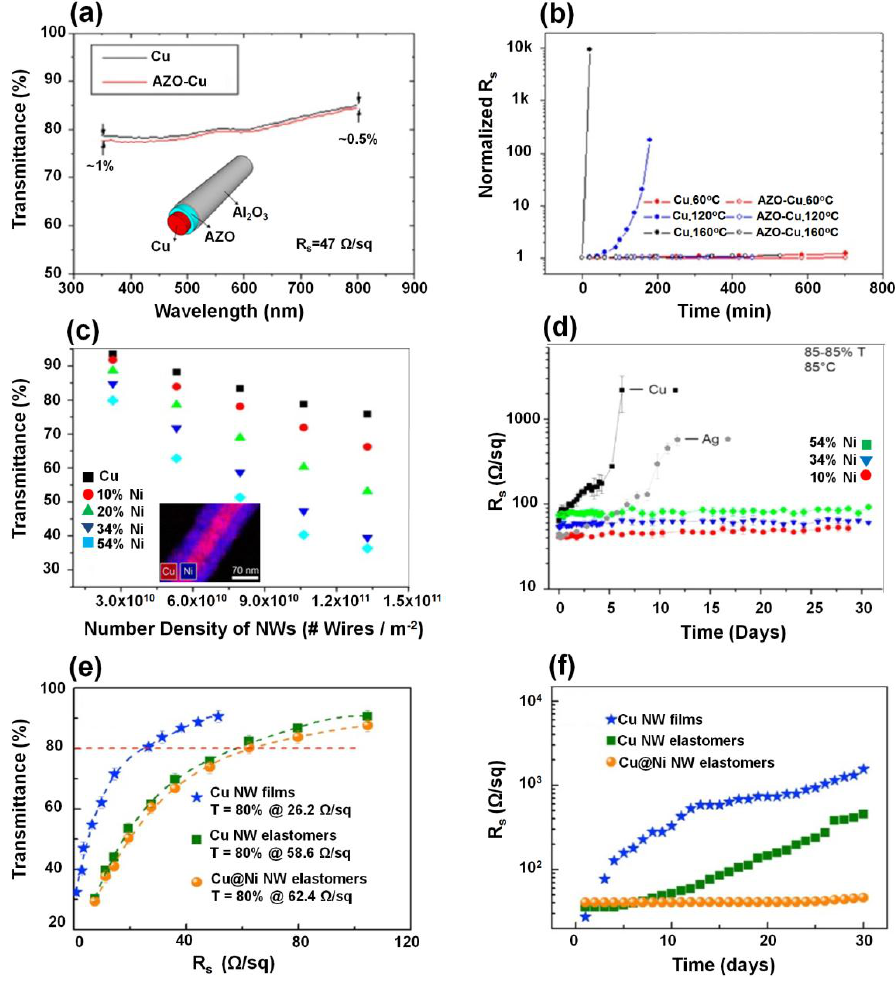
Figure 6. ( a ) Transmittance of electrospun Cu nanofibers before and after atomic layer deposition (ALD); inset is a cartoon (not to scale) of the Cu@AZO/Al 2 O 3 nanofiber ( b ) Normalized sheet resistance ( R s ) of bare and protected Cu NWs vs. baking time at 80, 120, and 160 °C. Solid circles refer to bare Cu nanofibers and hollow circles represent AZO-Cu nanofibers. In the case of bare Cu nanofibers at 120 and 160 °C, the resistance exceeded the multimeter limit (20 MΩ) in the end. (Reproduced with permission from [77]. Copyright American Chemical Society, 2012); ( c ) A plot of specular transmittance vs. number density of NWs, which shows the effect of increasing wire diameter on the film transmittance; inset is an energy-dispersive X-ray spectroscopy (EDS) mapping image of a cupronickel NW coated with 54 mol % nickel; ( d ) Plot of R s vs. time for films of Ag NWs, Cu NWs, and cupronickel NWs stored at 85 °C (Reproduced with permission from [78]. Copyright American Chemical Society, 2012); ( e ) Transmittance as a function of R s for various NW electrodes; ( f ) R s vs. time for various NW electrodes during exposure in the natural environment. (Reproduced with permission from [81]. Copyright American Chemical Society, 2014).